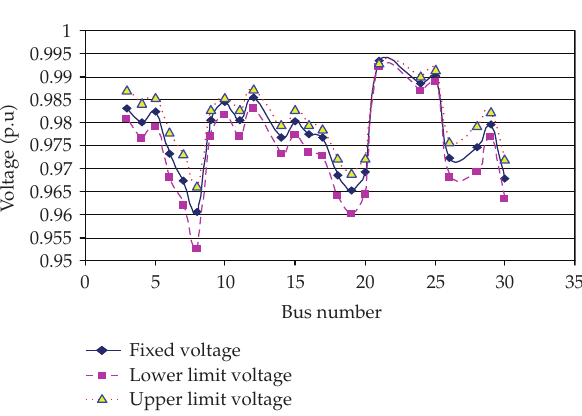
Figure 5: Voltage profile for load and line